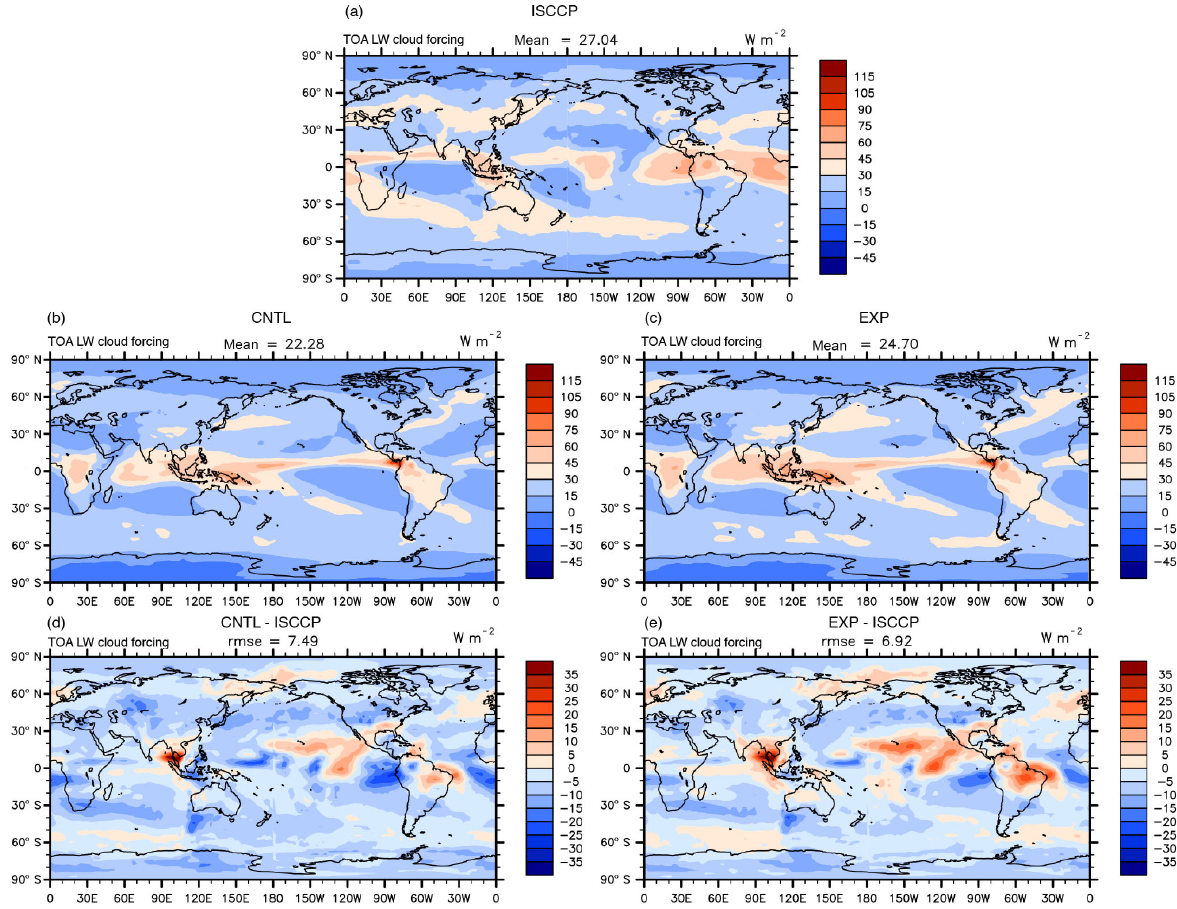
Figure 5. Same as Fig. 4 except for LWCF.